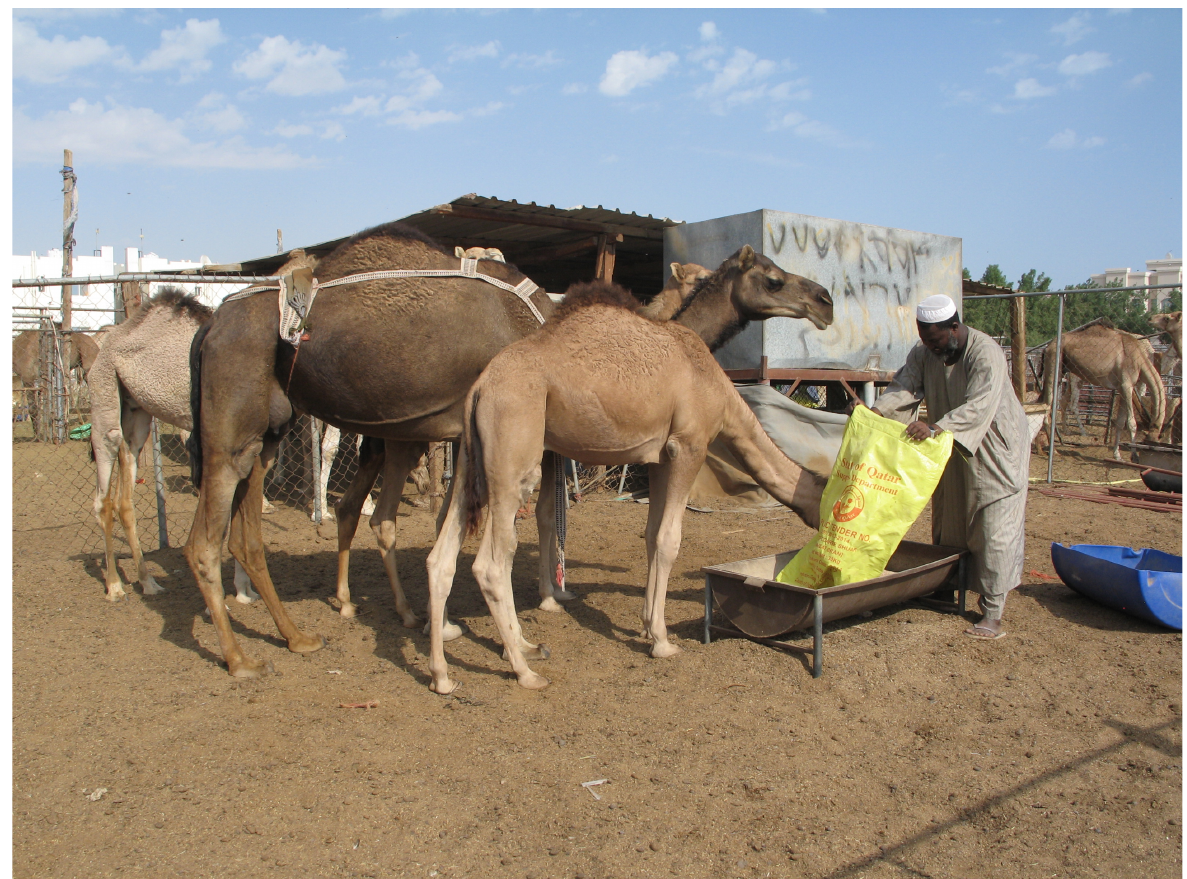
Figure 1. A Sudanese worker feeding camels in Central Market (Doha, November 2014). Source: Sarah